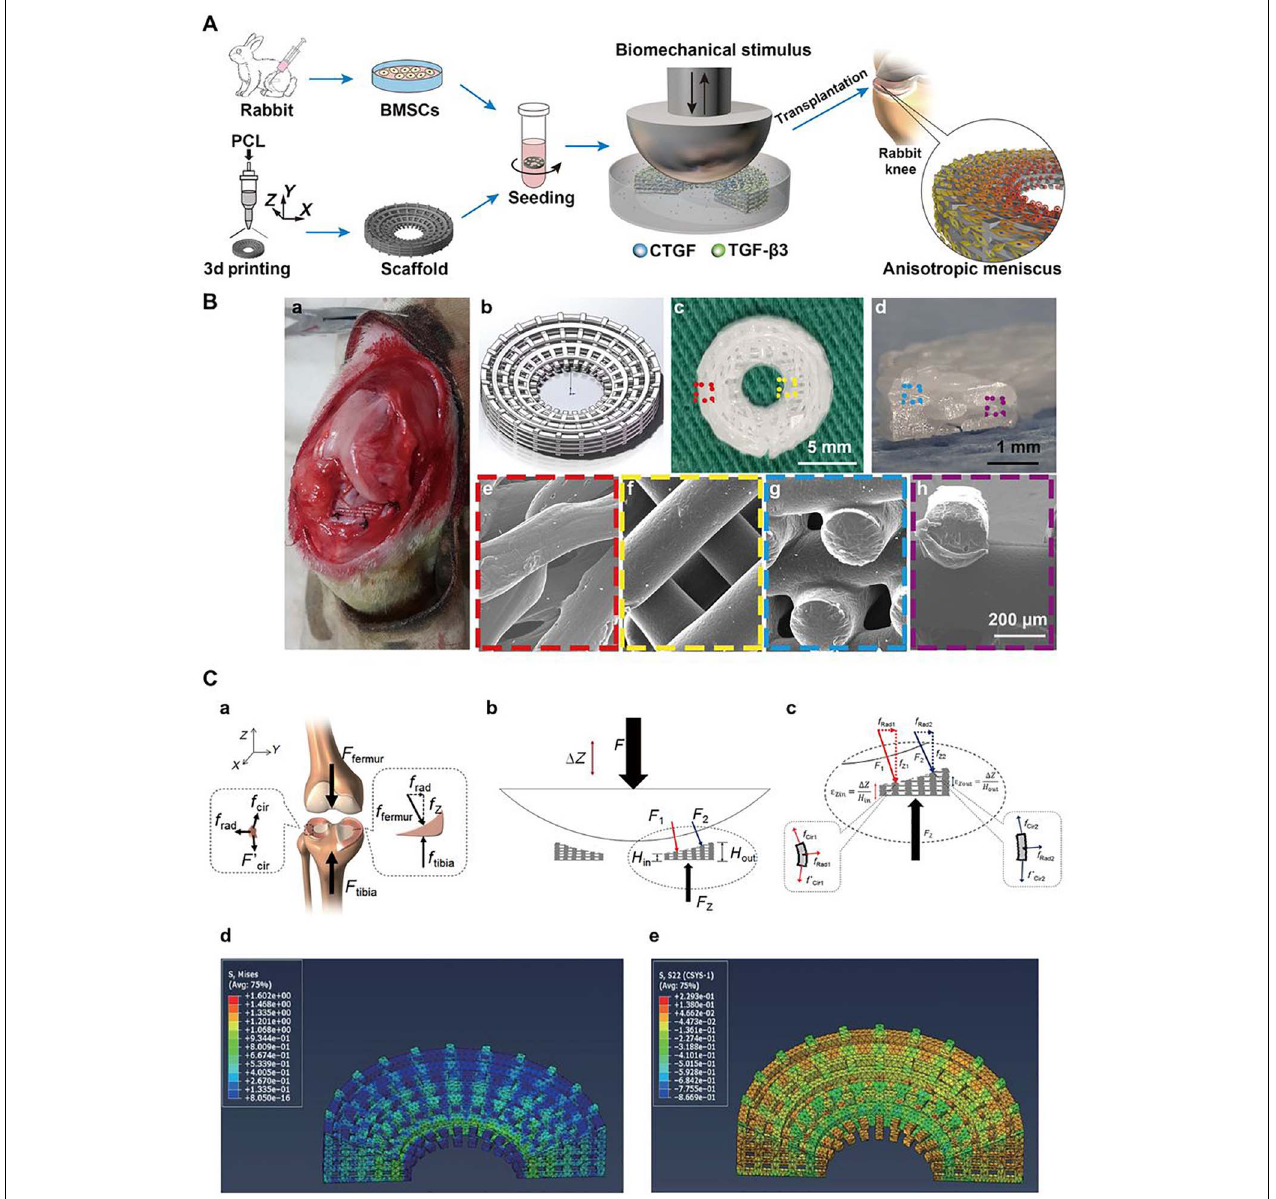
FIGURE 5 | Schematic diagrams for the reconstruction of a functional anisotropic meniscus. (A) Flowchart of stem cell-based strategies for the construction of a tissue-engineered meniscus with an anisotropic structure. BMSCs, bone marrow-derived stem cells. (B) 3D-printed PCL scaffold for implantation. (a) Photograph of rabbit knee during implantation. (b) 3D scaffold design model. (c,d) Top and cross-sectional views of the wedge-shaped circular PCL scaffold. (e,f) Top views of the outer and inner regions of the PCL scaffold obtained by SEM. (g,h) Cross-sectional views of the outer and inner regions of the PCL scaffold obtained by SEM. (e–h) Higher magnification images of regions outlined in c and d. (C) Biomechanical simulation. (a) Forces typically transduced by the knee meniscus in the human body. (b,c) Applied loading forces across the meniscal construct. (d,e) Calculated stress fields across the meniscal construct at 10% displacement of the loading plate. (d) von Mises stress distribution with a gradual decrease in stress from the internal to external rings. (e) Compressive circumferential stress in the internal rings and tensile circumferential stress in the external rings (reprinted from Zhang et al., 2019 with permission from